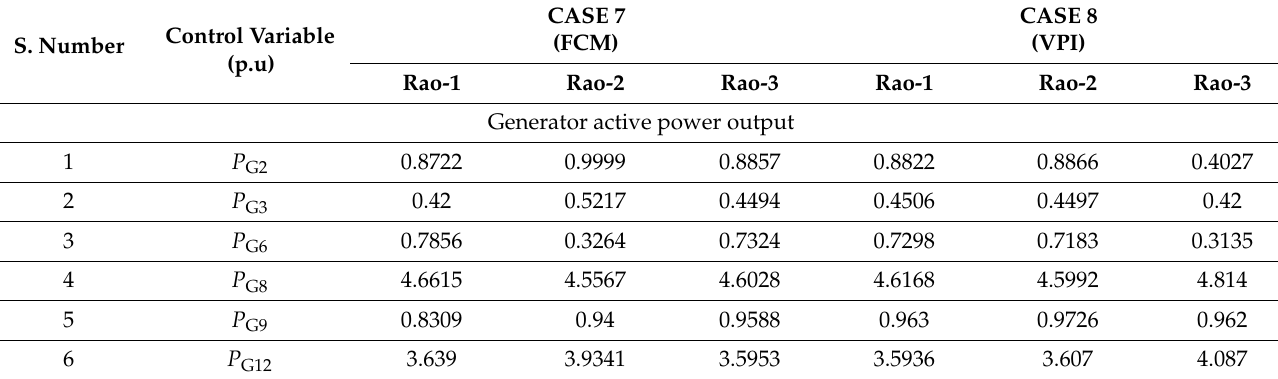
Table 12. Optimum values of control variables of Case 7 and Case 8 for the IEEE 57-bus system.